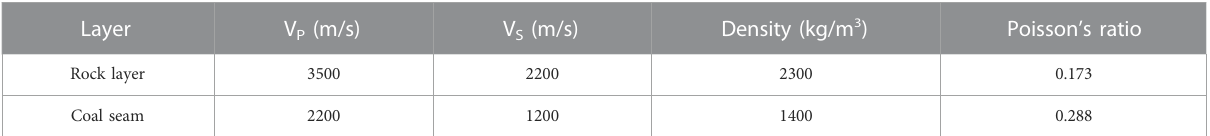
TABLE 2 Petrophysical parameters of the faulted coal seam